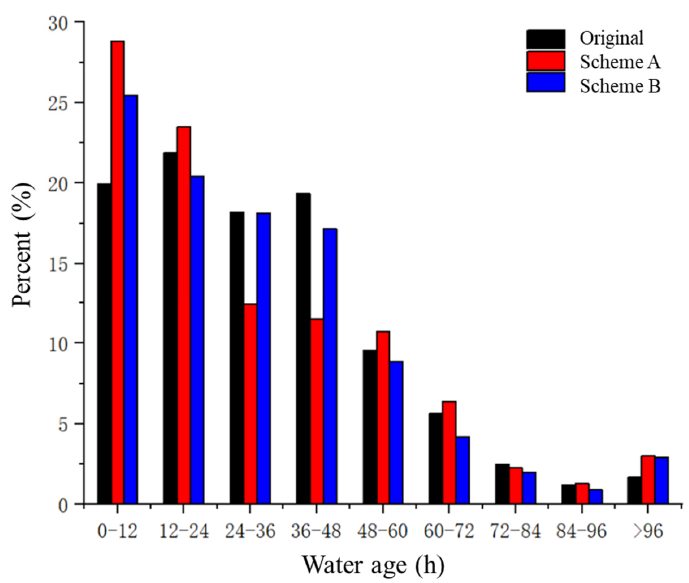
Figure 3. The water demand pattern of case WDN.